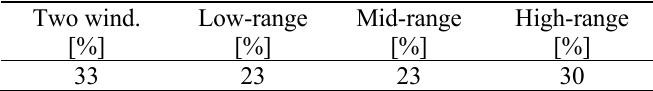
Table 6: The maximum errors of Ronkainen’s formula. Two wind.